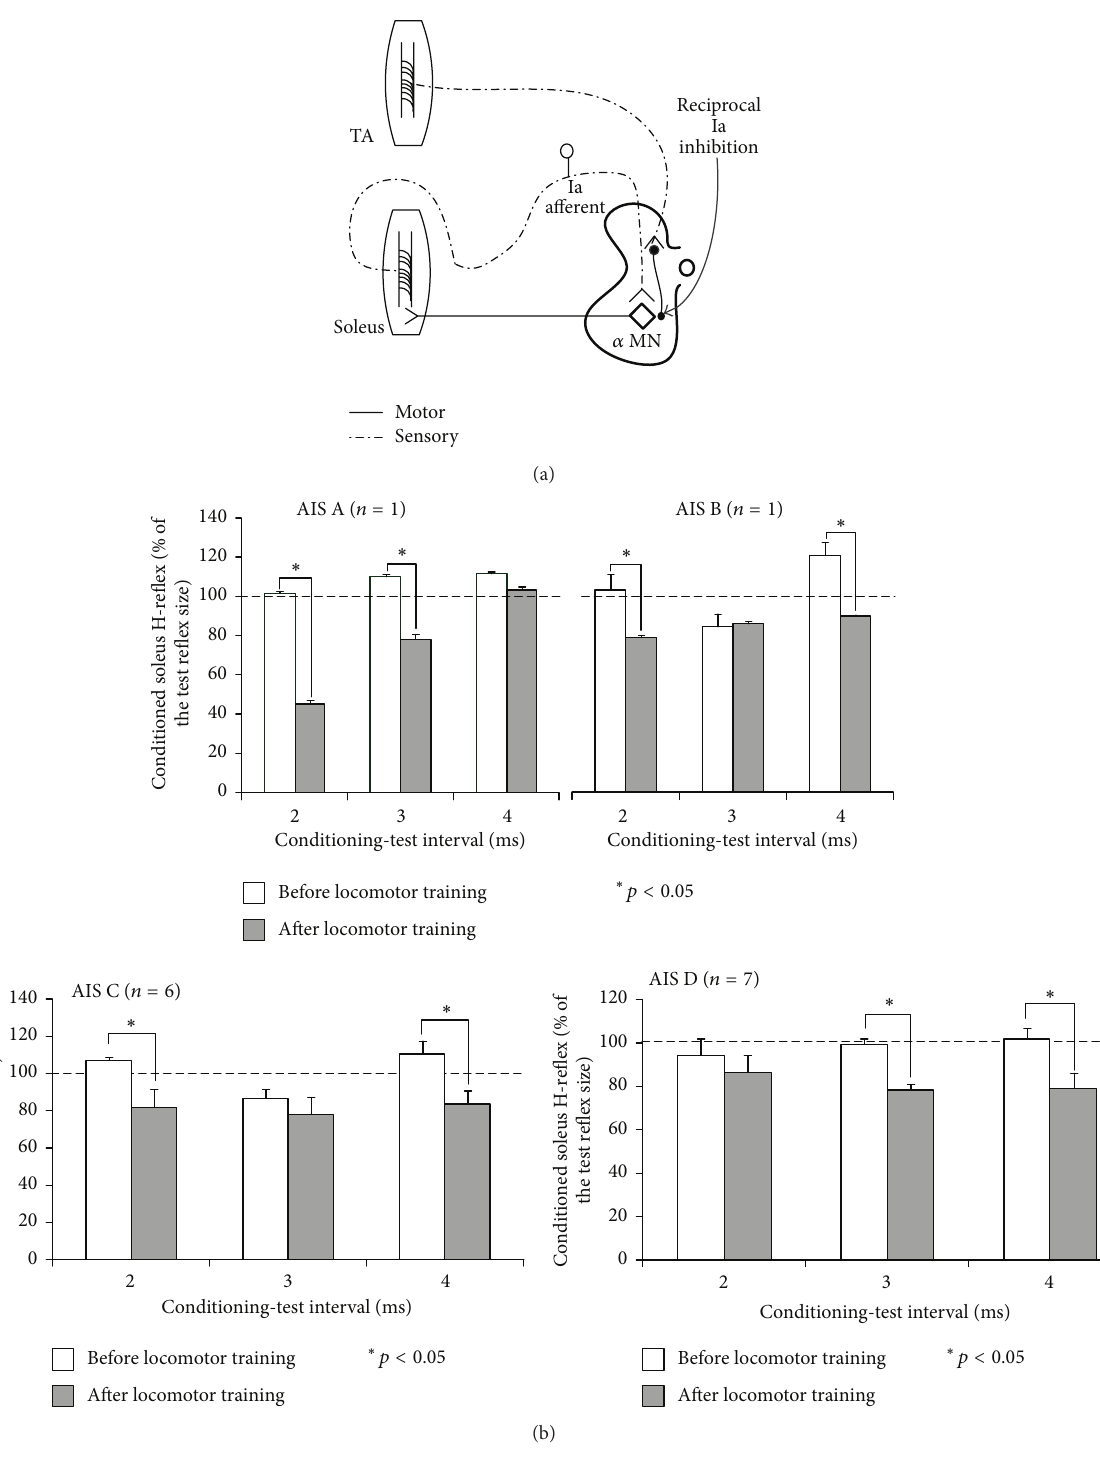
Figure4:FunctionalreorganizationofreciprocalIainhibitionafterlocomotortraininginSCI.(a)Schematicdiagramoftheneuronalpathway of reciprocal Ia inhibition mediated by a conditioning afferent volley induced by stimulation of the ipsilateral common peroneal nerve at short conditioning-test (C-T) intervals. (b) Mean amplitude of the conditioned soleus H-reflex as a percentage of the unconditioned H-reflex recorded at each C-T interval tested before and after locomotor training from the right leg, grouped per AIS, in the seated position. ∗ 𝑝 < 0.05 indicate statistically significant differences of the conditioned H-reflexes recorded before and after locomotor training. Data adopted and modified from